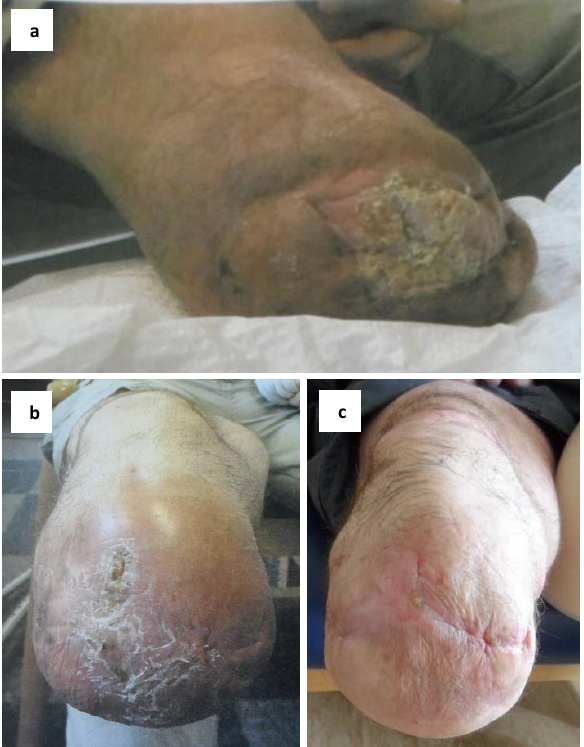
Figure 3: The condition of the Case #3 patient’s residual limb (a) in its worst condition in 2011, (b) in 2013 and (c) in March 2019, after continued use of a perforated liner (since 2016) with elevated vacuum suspension and hydraulic ankle (since August